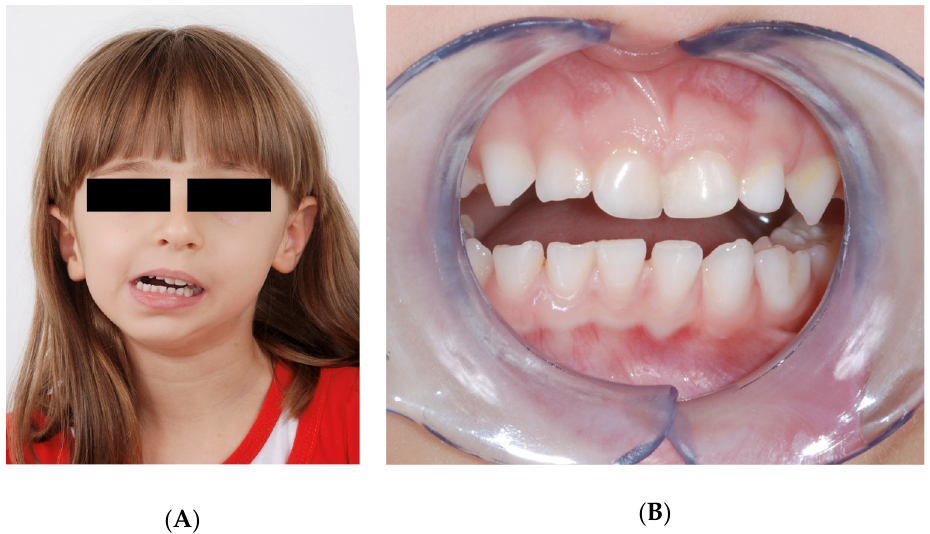
Figure 1. Frontal view when the patient was 5; ( A ) facial asymmetry characterized by a right deviation; ( B ) Maximum mouth opening was less than 10 mm.